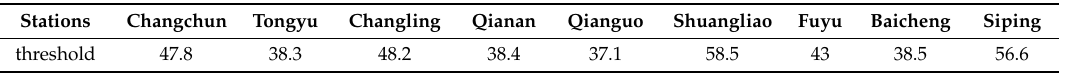
Table 2. The threshold of extreme precipitation